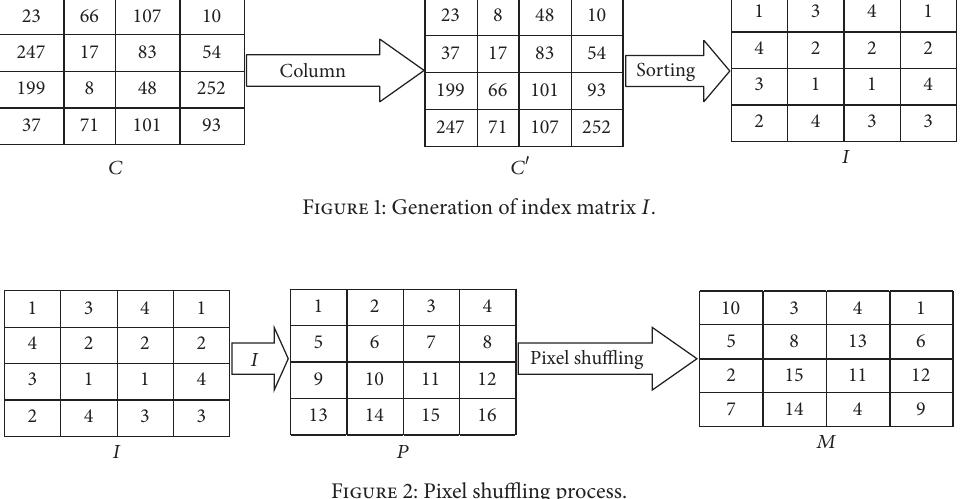
Figure 2: Pixel shuffling